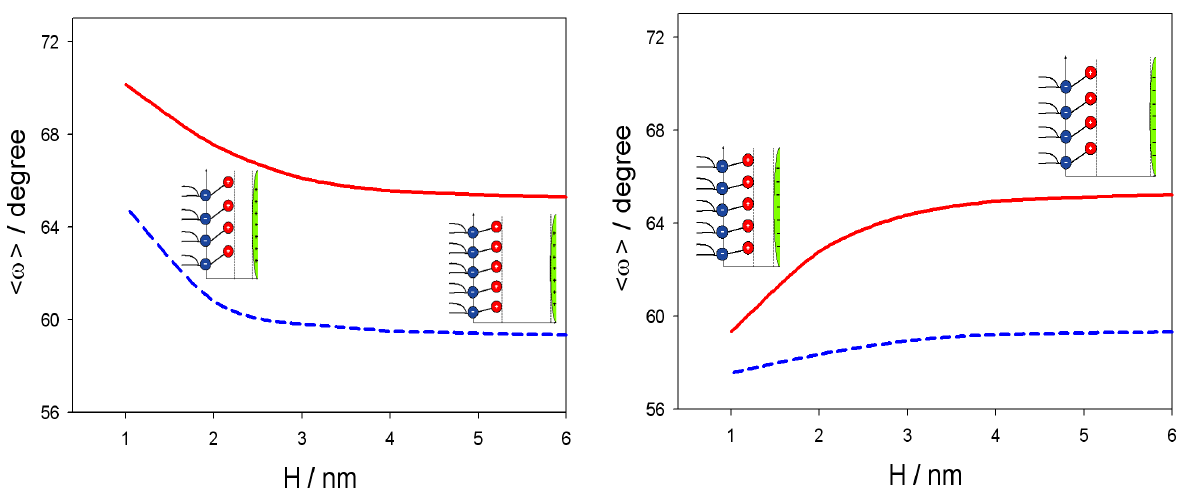
Figure 5. Average lipid dipolar headgroup orientation angle, < ! > (see, also, Figure 4), as a function of the distance ( H ) between the plane of the phosphate groups of dipolar (zwitterionic) headgroups and the surface of positively ( left panel) and negatively ( right panel) charged nanoparticle for the bulk concentration of salt, n two values of parameter, (cid:11) : 0.5 (full line) and five (dashed line). The values of the model parameters are: the dipole moment of water, p n =N = 55 mol = L 0 w A